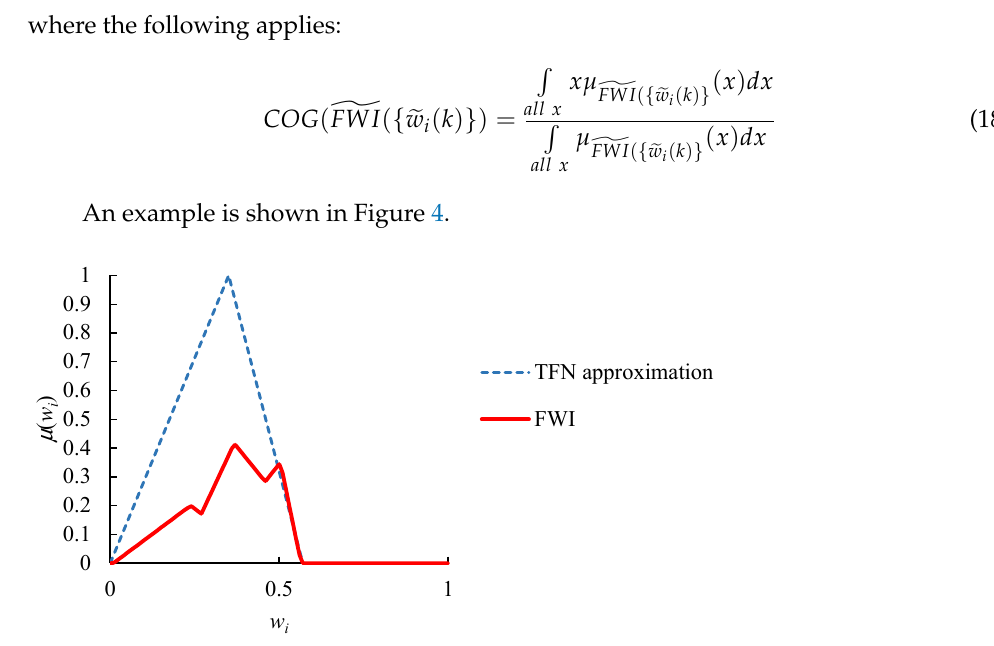
Figure 4. Approximating the aggregation result with a TFN.